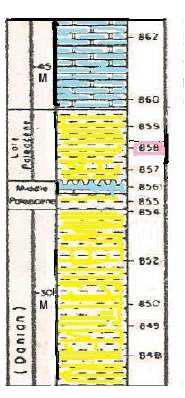
Figure 3: The stratigraphic position of shaley sample (858) of the holotype of Lenticuzonaria hodae Anan, n. sp. from the Late Paleocene of Tell Burma section, South Jordan (Futyan, 1976).